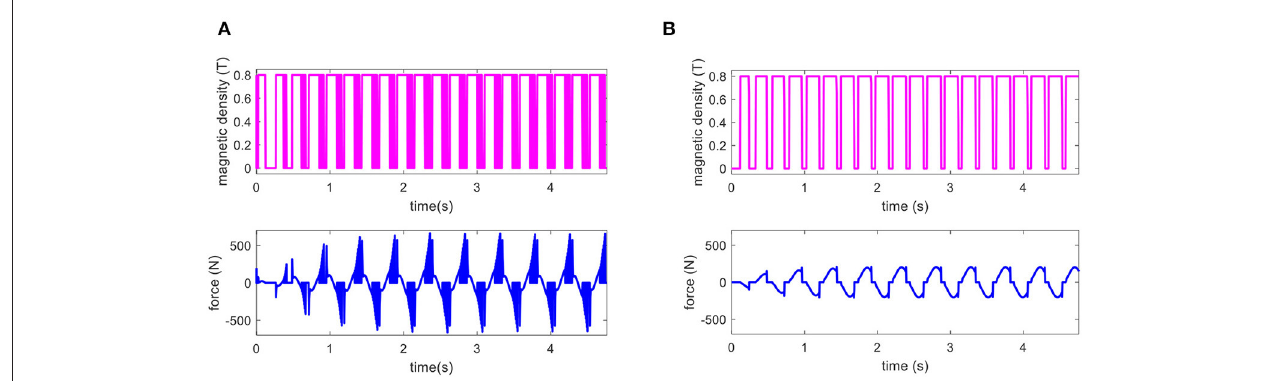
FIGURE 9 | The control input to the MRE-based isolator for harmonic excitation; (A) ON-OFF controller, and (B) adaptive NN controller.